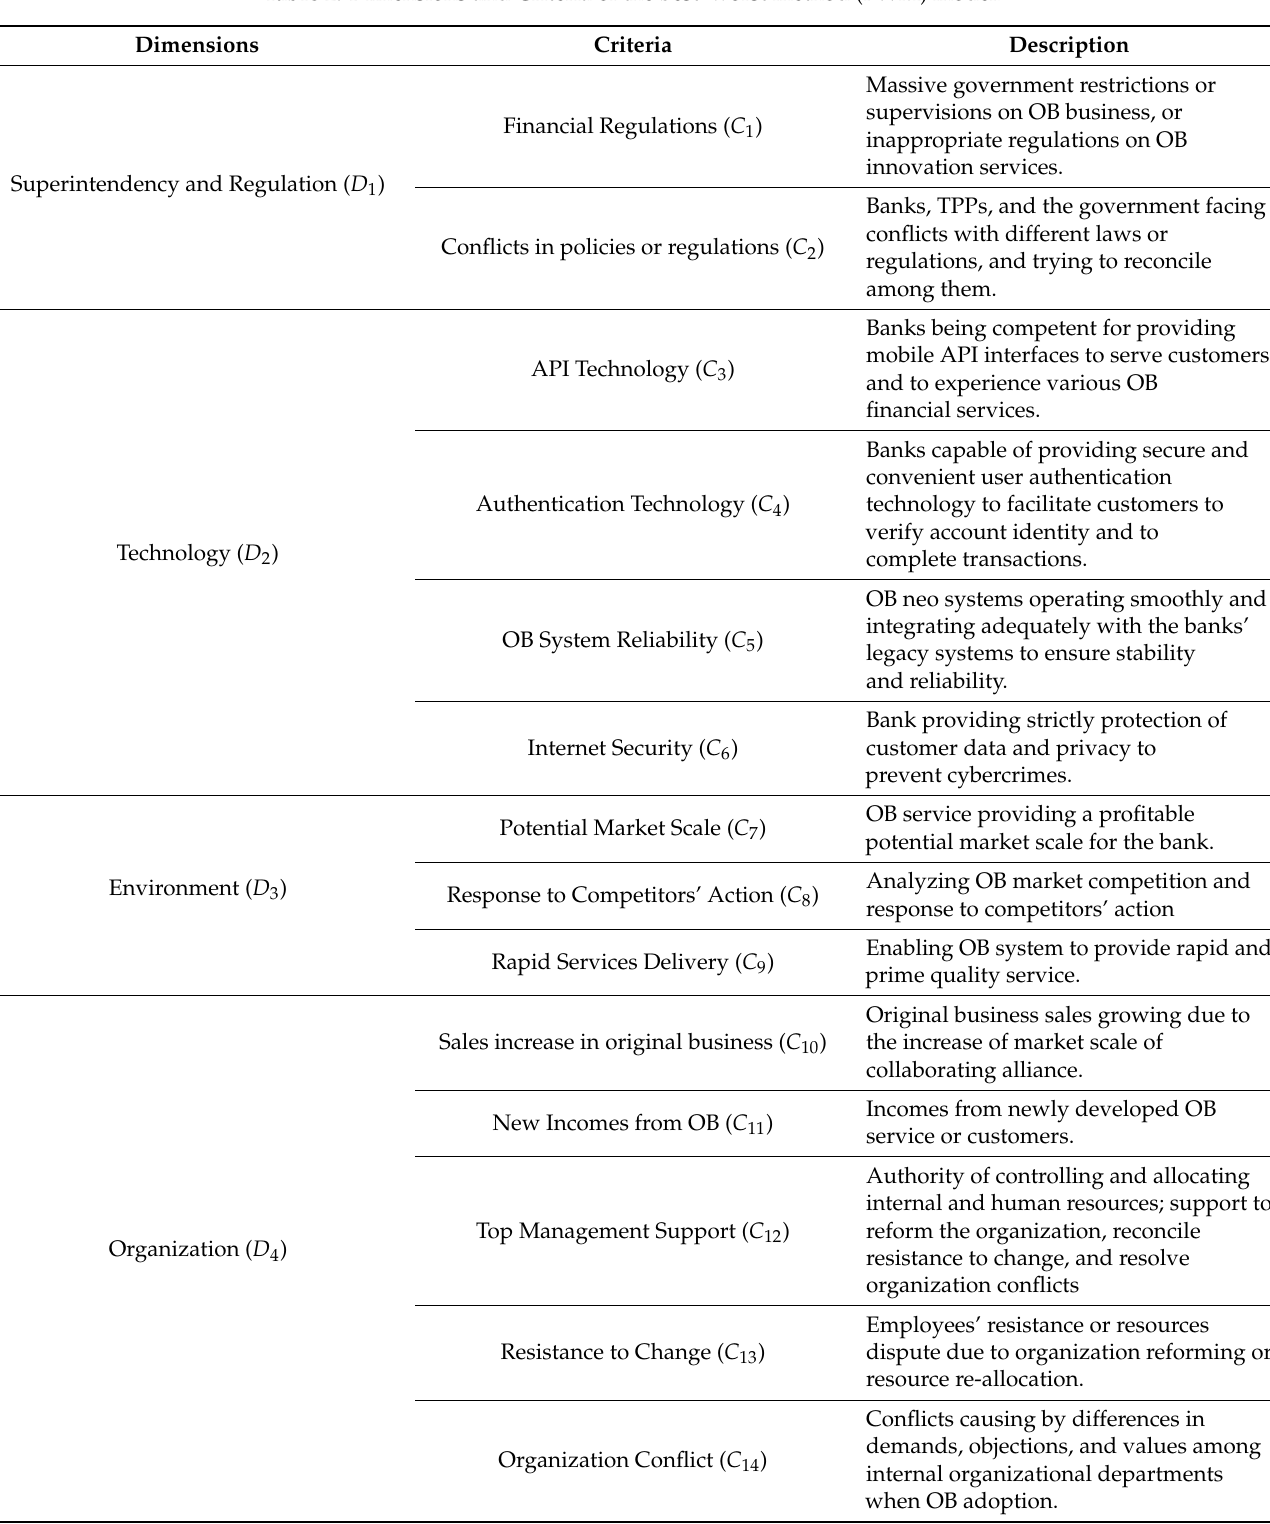
Table 2. Dimensions and Criteria of the best–worst method (BWM)